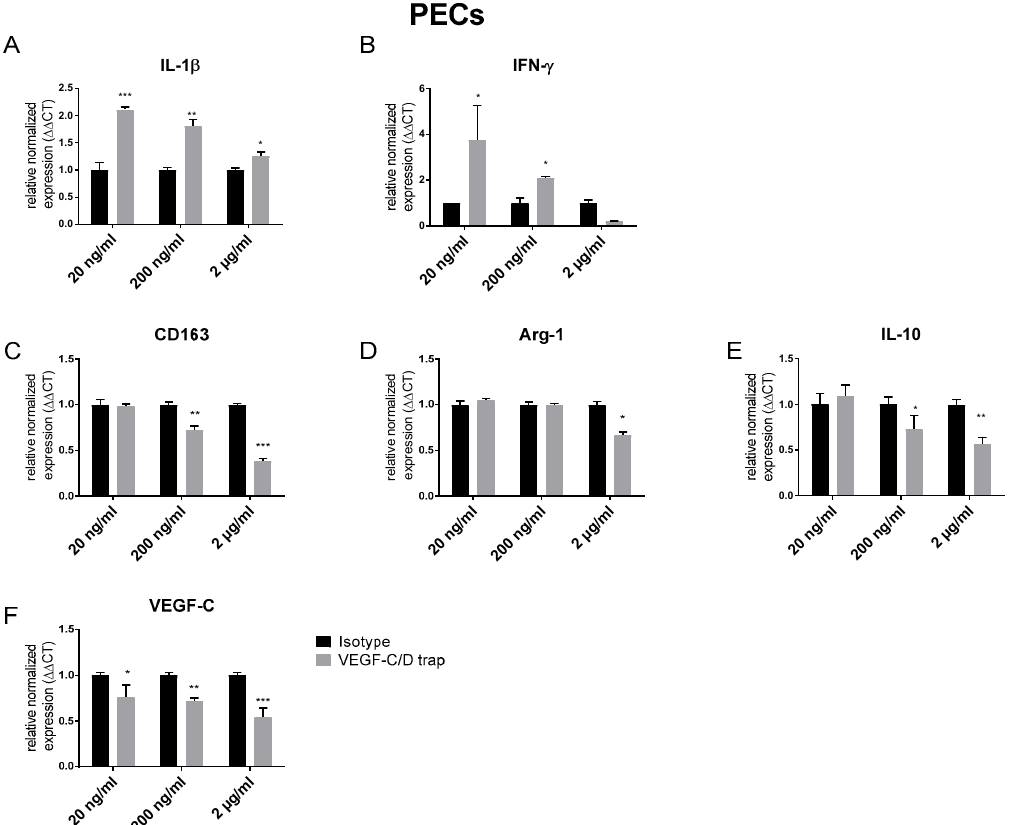
Figure 4. In vitor effect of VEGF-C/D Trap on pro- and anti-inflammatory markers in macrophages. ( A–B ) Murine Macrophages isolated from the peritoneum (Peritoneal Excudate Cells (PECs)) treated with different concentrations of VEGF-C/D Trap express increased levels of the proinflammatory cytokines IL-1 β and IFN- γ ; ( C–E ) in contrast, VEGF-C/D Trap treated PECs downregulate the immune regulatory markers CD 163 and Arg-1, as well as the immune modulatory cytokine IL-10; ( F ) VEGF-C/D Trap downregulates the expression of VEGF-C. Expression was compared with PECs treated with the same concentrations of the corresponding IgG isotype control. (n = 3, * p = 0.05, ** p = 0.001, *** p = 0.0001).